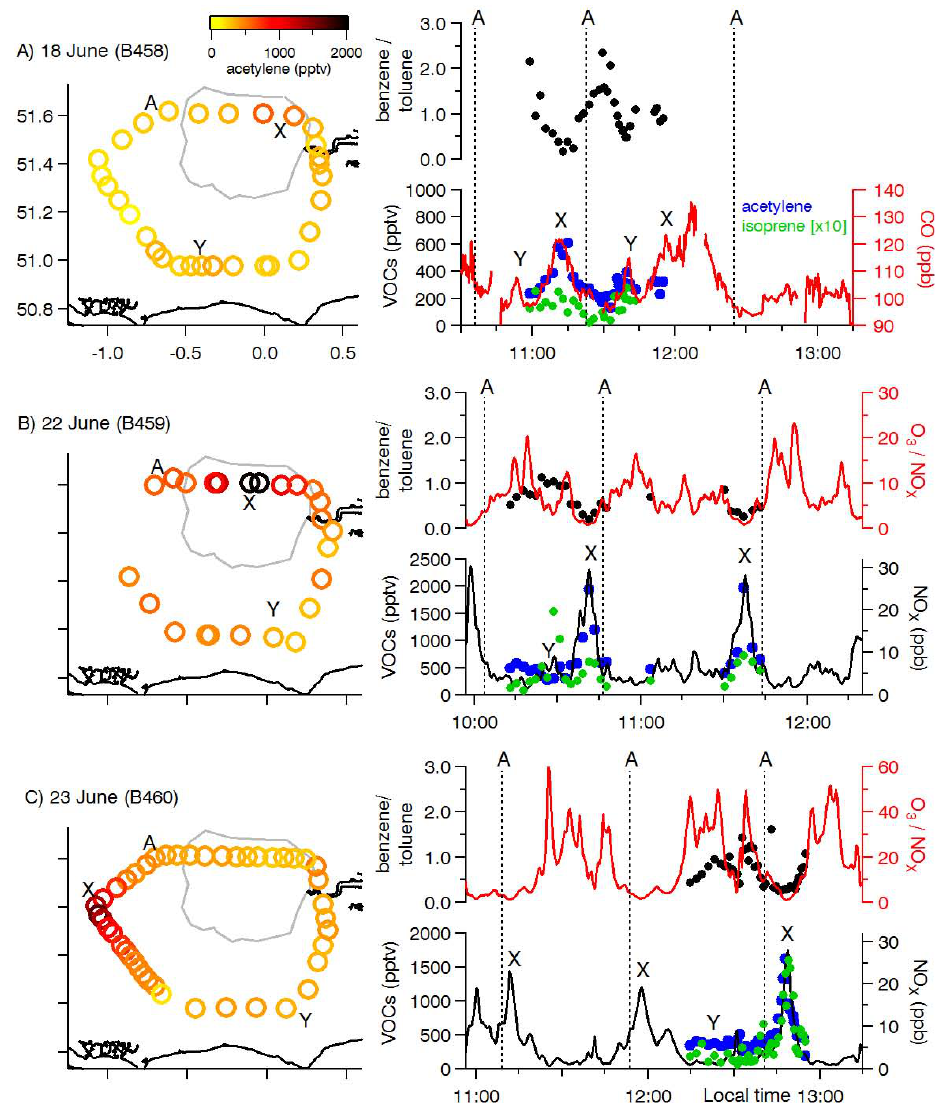
Fig. 5. Mixing ratios for acetylene (C 2 H 2 ), isoprene, nitrogen oxides (NO x ), carbon monoxide and ratios of ozone-to-nitrogen and benzene- to-toluene measured around London for three EM25 flights. NO x mixing ratios were unavailable for the 18 June flight so CO is shown instead. The approximate location of the London plume is indicated by “X”. Additional features of interest are shown by “Y”. Point “A” on each map corresponds to the dashed lines on each time series. The flight direction for all days was